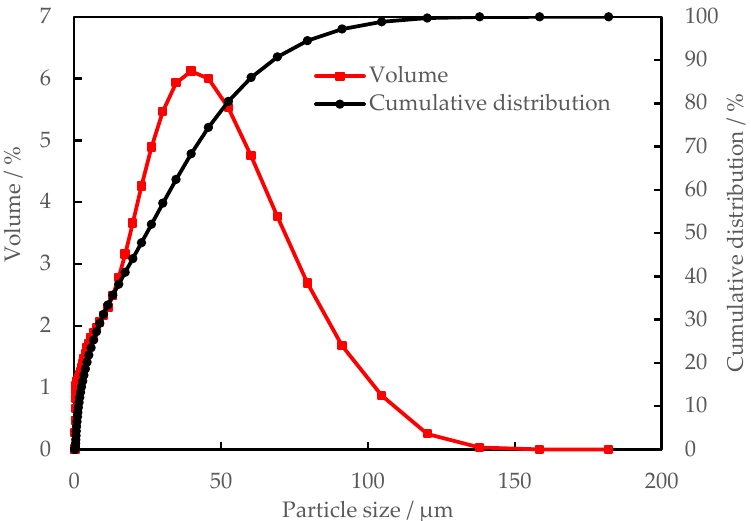
Figure 1. Particle size distribution of phosphorus tailing.